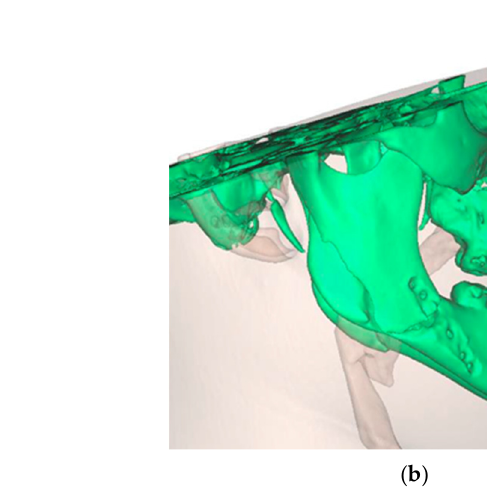
been planned. The postoperative CT showed a deviation of − 0.8 ◦ with an SNA angle of